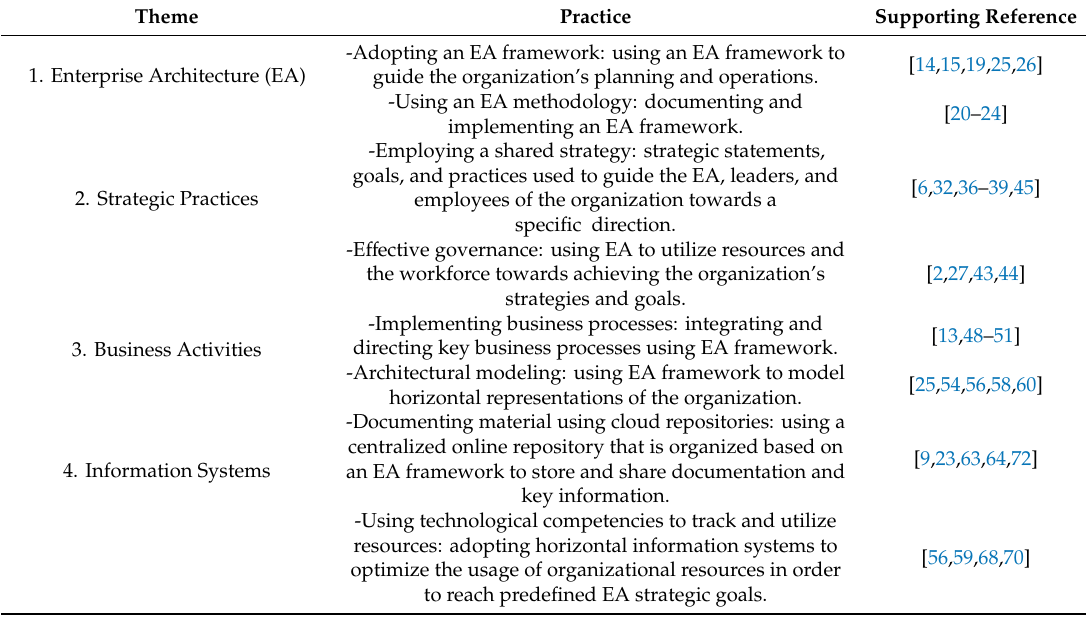
Table 1. Critical enterprise architecture best practices (EABPs) found in the literature.